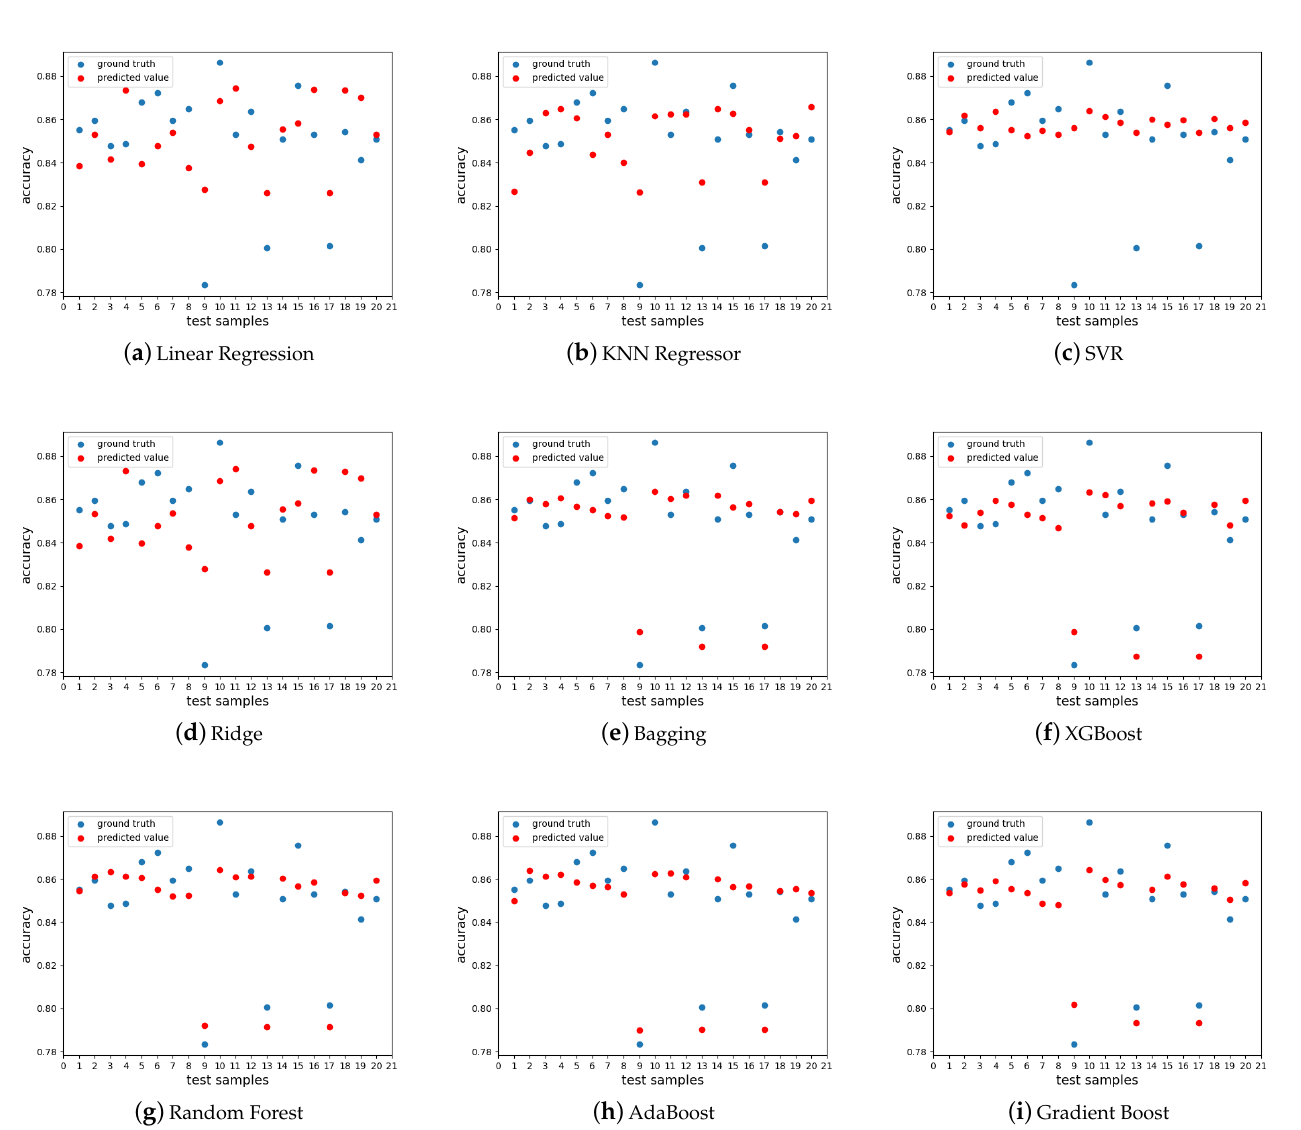
Figure 10. Prediction results of test samples. ( a – i ) are the prediction results for each surrogate model. The blue points represent the true values, and the red points represent the predicted